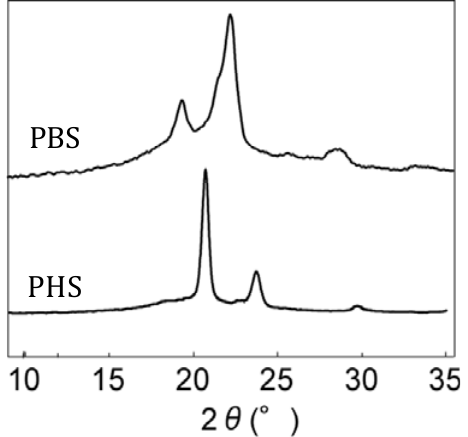
Figure 3. Wide angle X-ray diffraction spectra of PBS and PHS